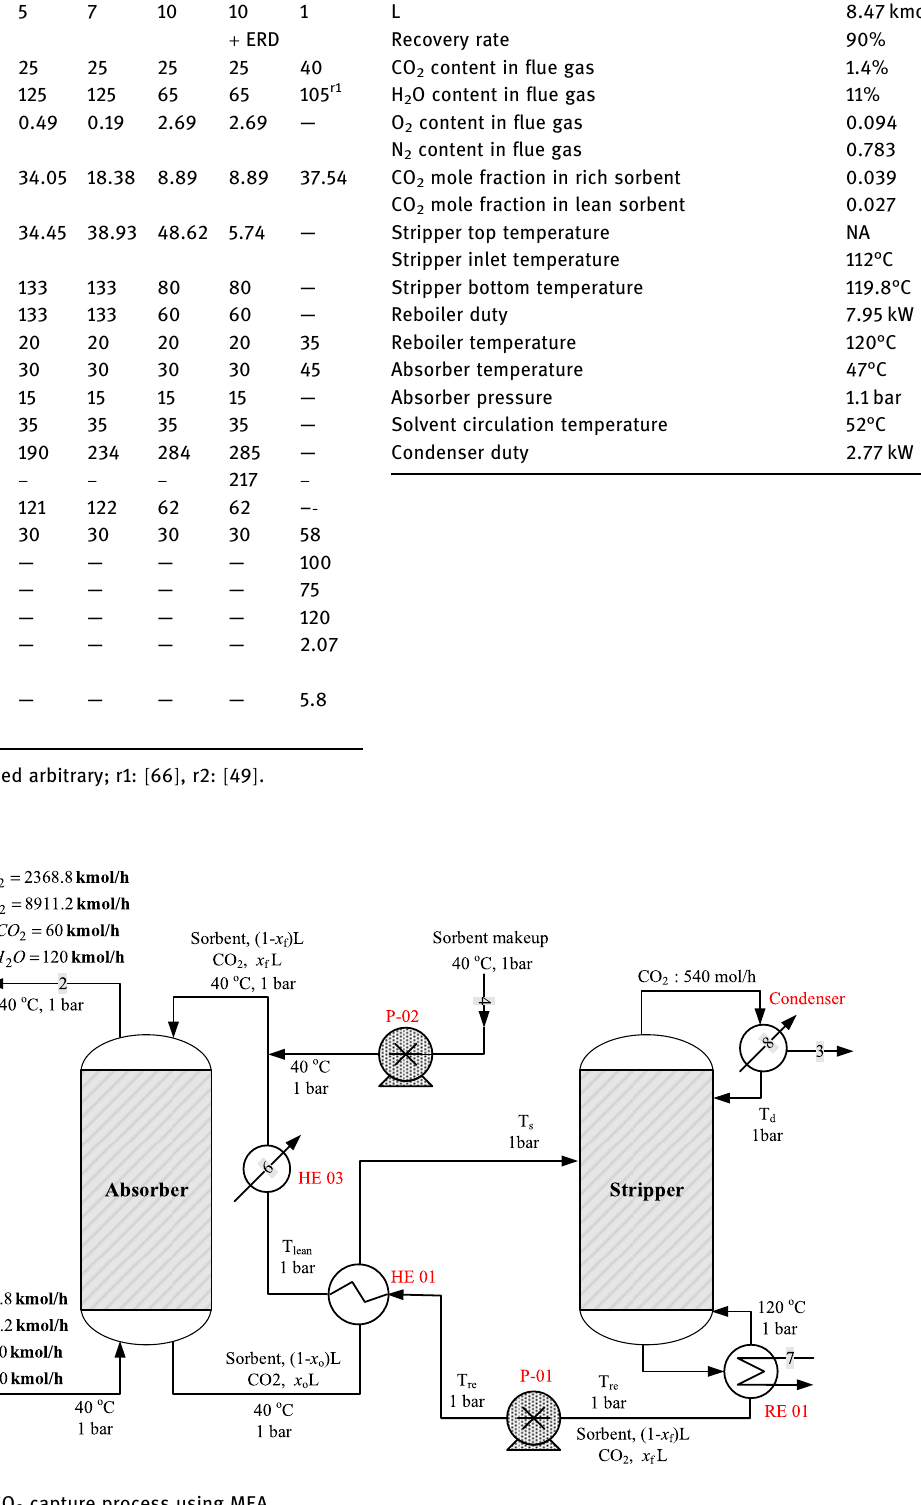
Figure A2: Schematic of CO 2 capture process using MEA.